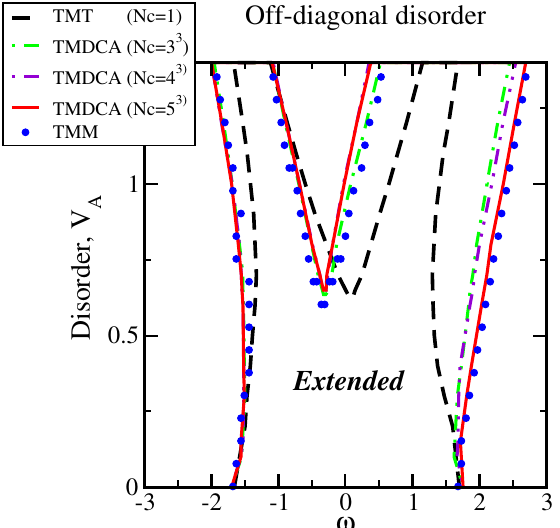
Figure 34. Disorder-energy phase diagram of the A-B binary alloy model with off-diagonal and diagonal disorder. Parameters used are t AA = 1.5, t BB = 0.5, t AB = 1.0, and c A = 0.5. The mobility edges obtained from the TMT N c = 1 (black dashed line), TMDCA N c = 3 3 (green dot-dashed line), N c = 4 3 (purple double-dot-dashed line) and N c = 5 3 (red solid line), and the transfer matrix method (TMM) (blue dotted line). The single-site N c = 1 strongly underestimates the extended states region especially for higher values of V A . The mobility edges obtained from the finite cluster TMDCA ( N c > 1) converges gradually with increasing N c and shows good agreement with those obtained from the TMM, in contrast to the single-site TMT. See the text for parameters and details of the TMM implementation. Reprint from